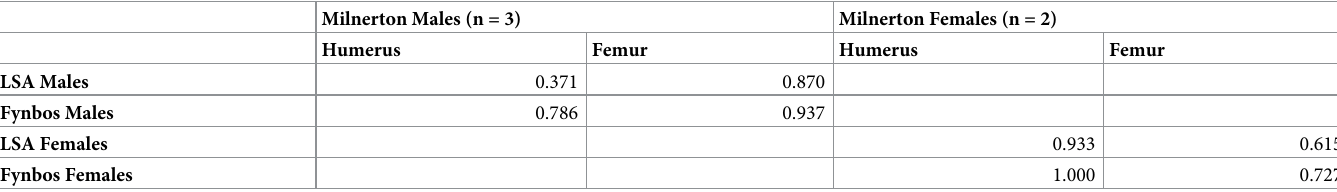
Table 5. Mann whitney U comparisons of Lagoon Beach males and females to Later Stone Age fynbos biome comparators [57] (p-values). Distal right humerus and midshaft femur body-size-standardized J